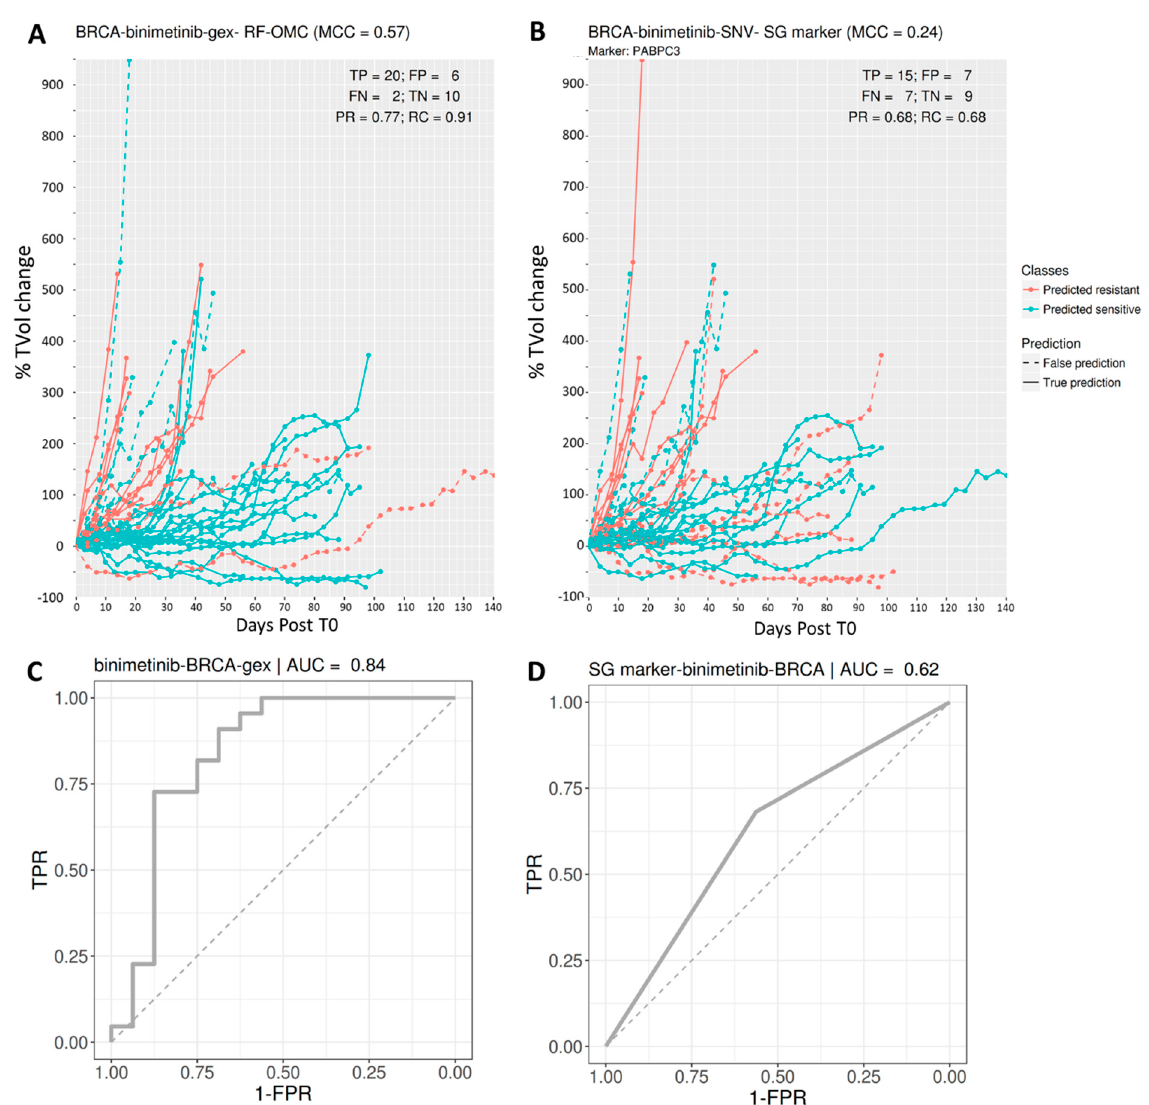
Figure 3. Predicting BRCA PDX response to the MAPK inhibitor binimetinib. (Upper) Visualisation of tumour response prediction for test PDXs. Each line represents one PDX. The vertical axis shows the % of tumour change relative to the tumour volume at time zero (T0; i.e., immediately before the first administration of the drug), and the horizontal axis shows when measurement time in days after T0. From the legend, red discontinuous lines represent false negatives (responsive PDXs that were predicted to be non-responsive), and blue discontinuous lines represent false positives (non-responsive PDXs that were predicted responsive). The better the predictor is, the higher the proportions of lines at the bottom appear in blue (higher recall) and at the top in red (higher precision). ( A ) Binimetinib (14 fts) : RF-OMC model predicts BRCA tumour response to binimetinib by optimally combining the expression levels of only 14 genes (CRB3, NDUFA1, MPG, ECI1, ING2, KIF9, TSTD1, FAM100A, TCEAL3, HAGH, PEX11G, SNORA72, SNORA70 and PIN1). A high level of predictive accuracy was achieved on PDXs not used to train the model: MCC = 0.57 (PR = 0.77 and RC = 0.91). ( B ) Binimetinib (1 fts) : Using the same input data and evaluation protocol, the best single-gene marker of binimetinib sensitivity was the mutational state of PABPC3. The RF-OMC model obtained a substantially higher level of prediction than that of this standard single-gene procedure: MCC = 0.24 (PR = 0.68 and RC = 0.68). ( C , D ) ROC curves and their AUC values to compare the discrimination offered by both models across all possible operating thresholds. The corresponding AUC value was indicated on the top of the ROC curve. This alternative performance metric also assigns higher predictive performance to the multi-gene RF-OMC model.